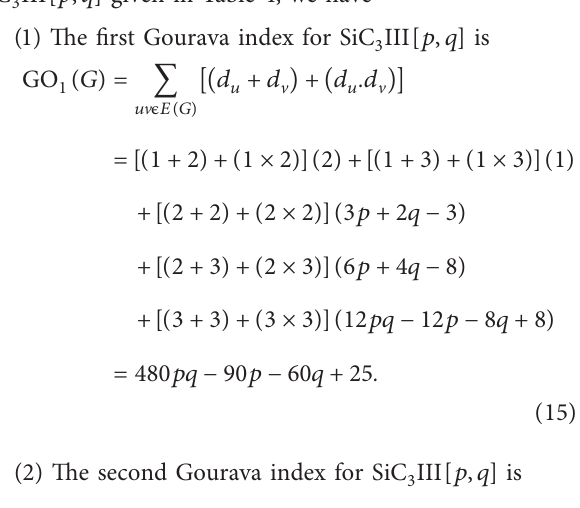
Table 3: Degree-based edge partition of Si